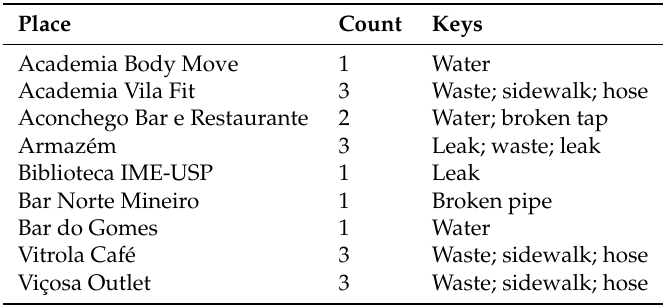
Table 4. Sample of tuples returned by query